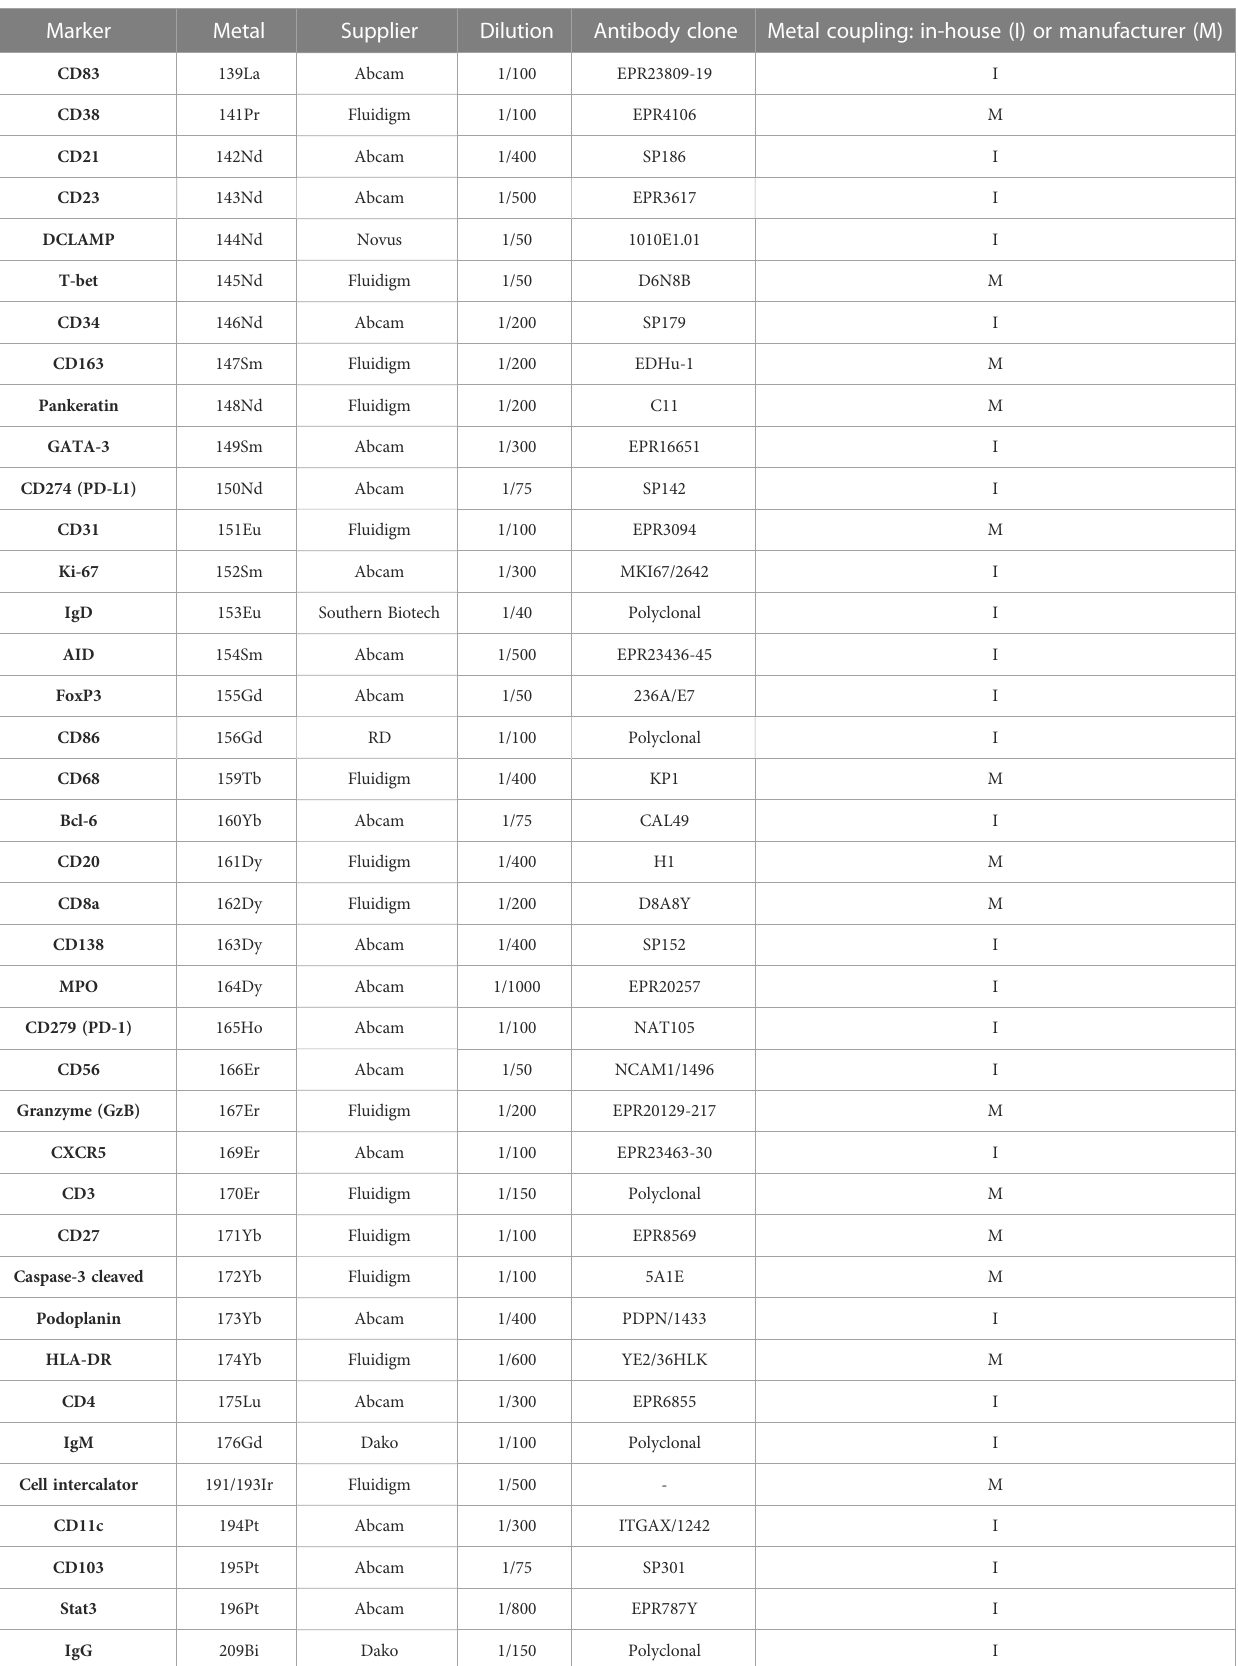
TABLE 2 Panel of markers and corresponding metals-labeled antibodies for tertiary lymphoid characterization.